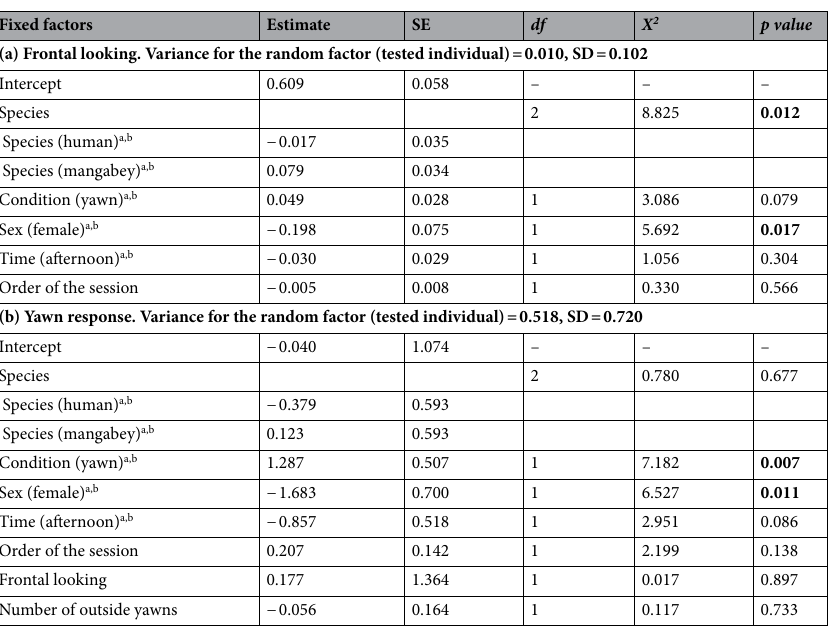
Table 1. (a) Estimated parameters (Estimate), Standard Error (SE), and results of the likelihood ratio tests ( χ 2 ) of the LMM (gaussian distribution) with Frontal Looking as response variable (Model 1a ). (b) Estimated parameters (Estimate), Standard Error (SE), and results of the likelihood ratio tests ( χ 2 ) of the GLMM (binomial error distribution) with Yawn Response as response variable (Model 1c ). For both the models the sessions were 102. Significant values are in bold. a Estimate ± SE refers to the difference of the response between the reported level of this categorical predictor and the reference category of the same predictor. b These predictors were dummy coded, with the “Species (Hamadryas)”, “Condition (Control)”, “Sex (Male)”, “Time (Morning)” being the reference categories.